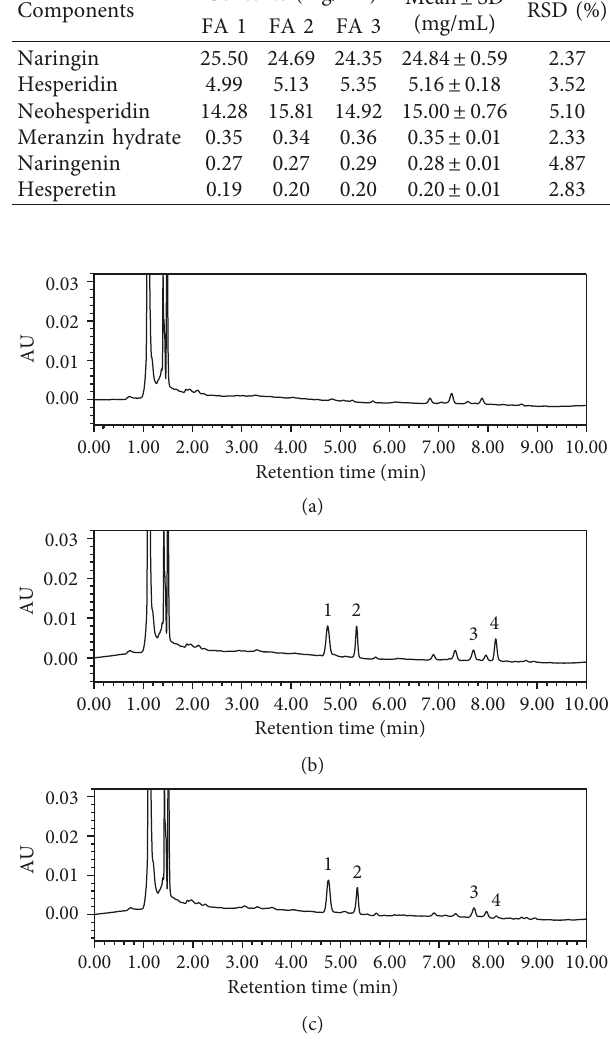
Figure 3: Typical chromatograms of the blank plasma (a), the blank plasma sample spiked with analytes (b), and plasma sample of 30min following oral administration of FA decoction (c) at 284nm. 1: SMZ; 2: meranzin hydrate; 3: naringenin; 4: